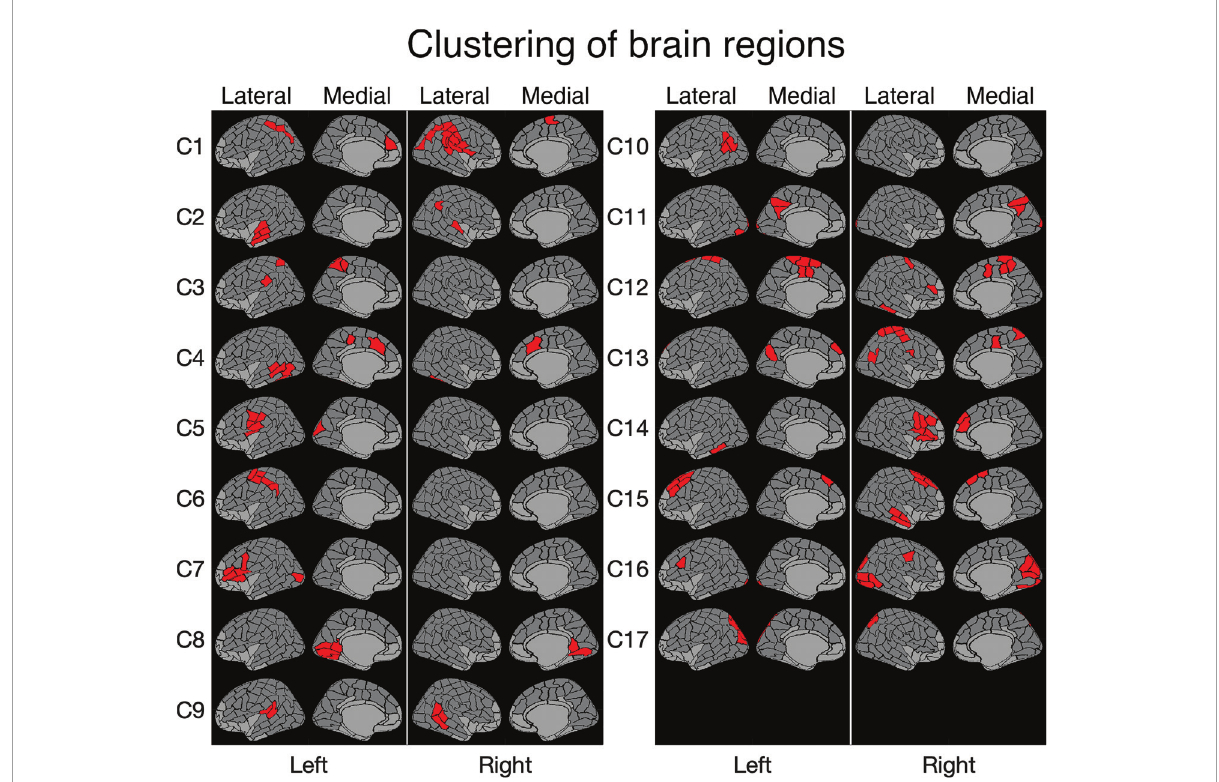
FIGURE3 Clustering of brain regions. Level 17 of a clustering tree (used in the analyses). The deep medial and anterior frontal areas plotted in light gray were omitted from the analysis. Clusters are ordered according to the optimal leaf order and marked with labels C1–C17 (cf. Figure 2